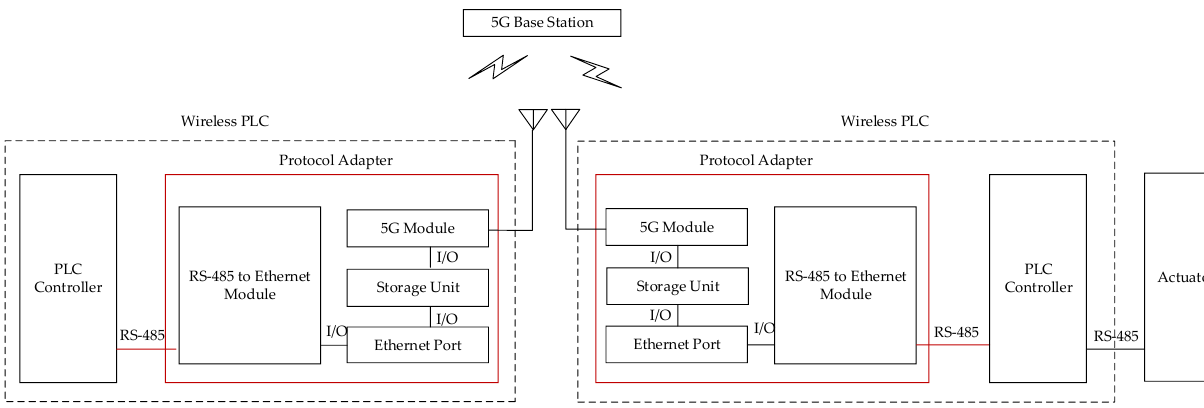
Figure 8. Hardware structure of wireless PLC for Modbus RTU.